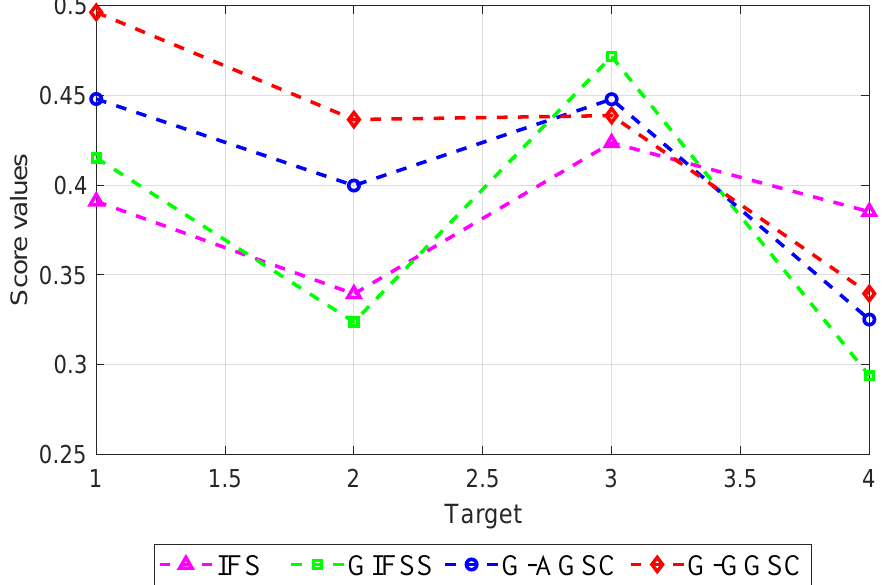
Figure 7. The score values of the targets under different methods in the proposed index system.